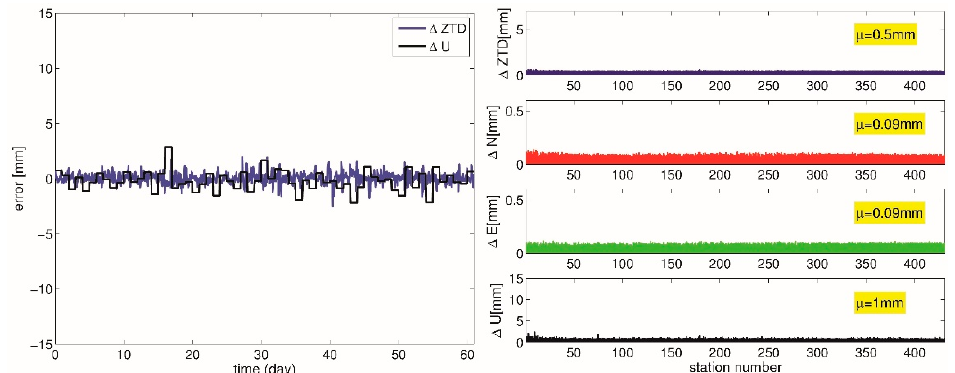
Figure 6. Results for the fifth simulation experiment. Left panel: the error in the ZTD and the error in the station up-component for the POTS station as a function of time. Right panel: the station-specific RMSE for the ZTD (top), the gradient components (middle), and the station up-component (bottom). The number with yellow background corresponds to the averaged RMSE of the respective parameter.